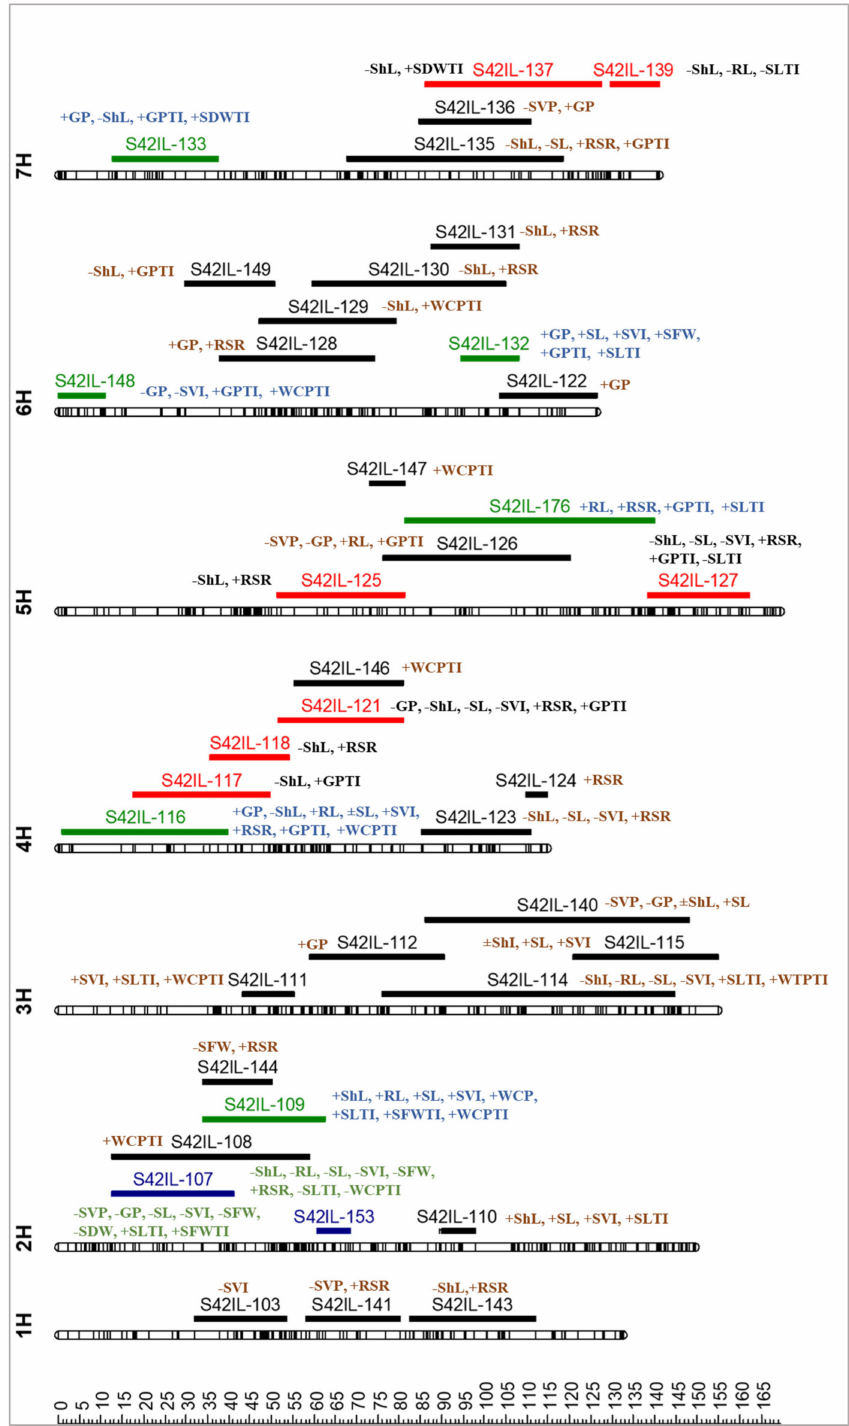
Figure 3. Localization of the most significant QTL in the S42ILs associated with germination- and seedling growth-related traits under control and salinity treatments. QTL are placed around the S42ILs, indicated by trait abbreviations. The sign indicates an increasing (+) or decreasing ( − ) Hsp effect. Green ILs indicate the most favorable effects of Hsp alleles, blue ILs indicate the most unfavorable effects of Hsp alleles, and red ILs indicate verified and validated QTL with previously published QTL in adult barley